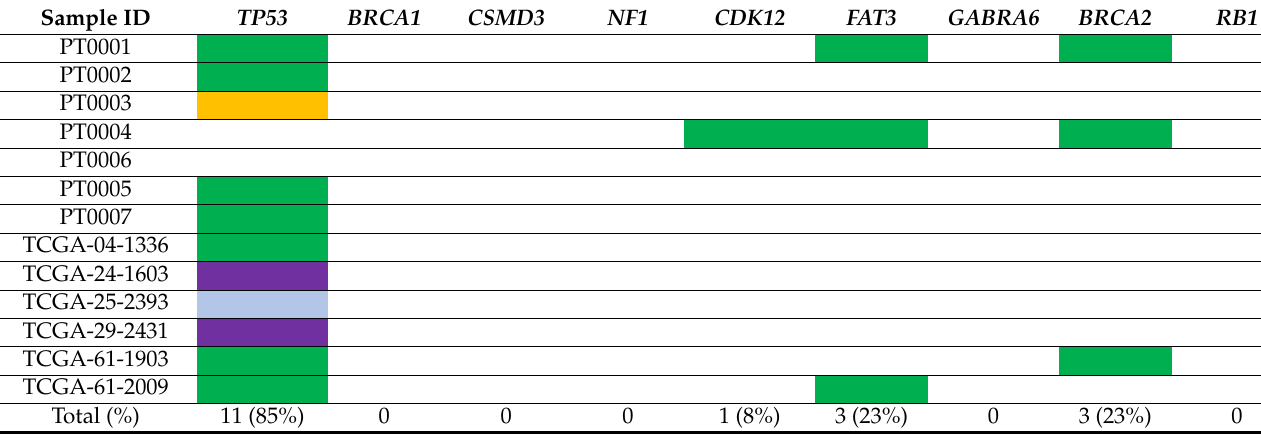
Colors legend: green means missense; yellow means splice; violet means frameshift; blue means